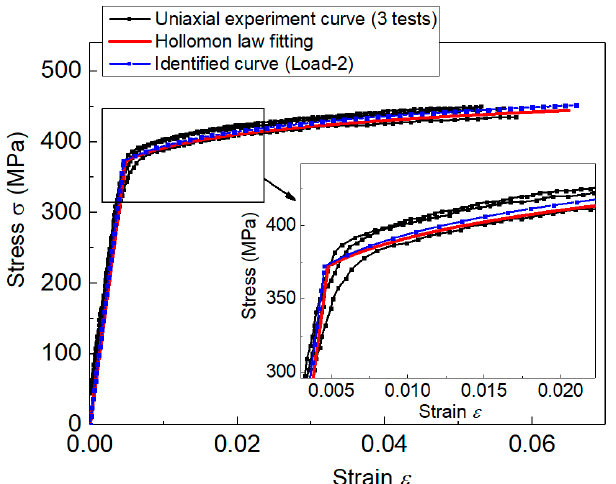
Figure 8. Comparison of the inverse identified stress–strain curve (Load-2) with the uniaxial exper- iment data.